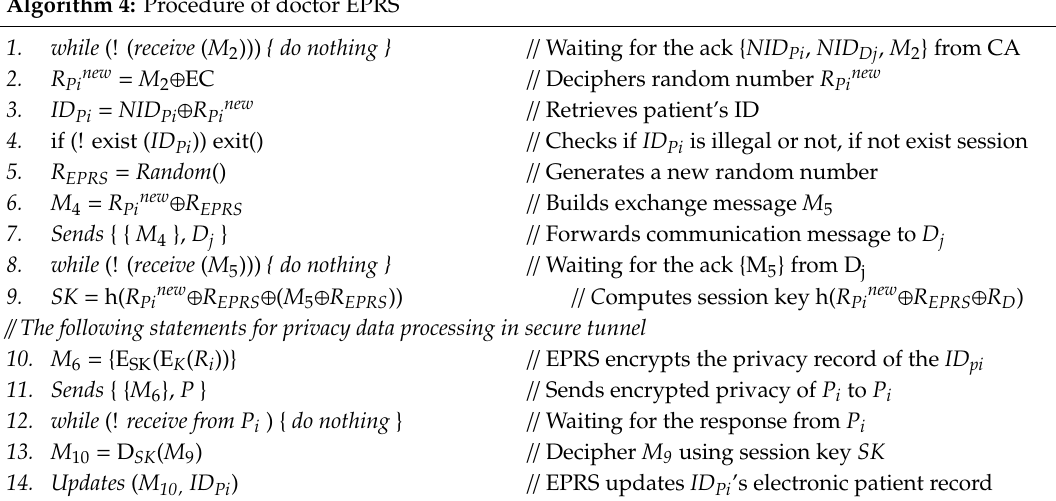
Algorithm 4: Procedure of doctor